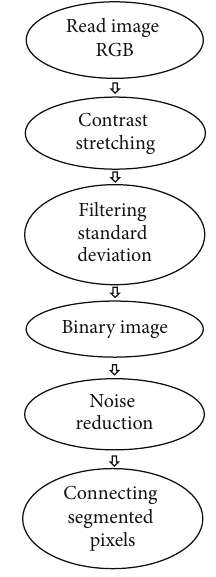
Figure 2: Methodology flow